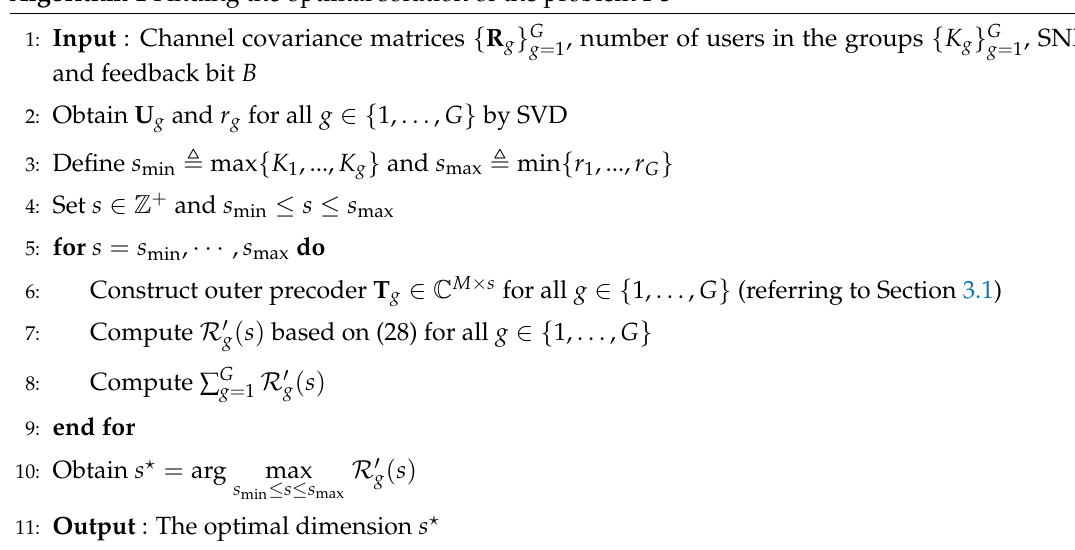
Algorithm 1 Finding the optimal solution of the problem P